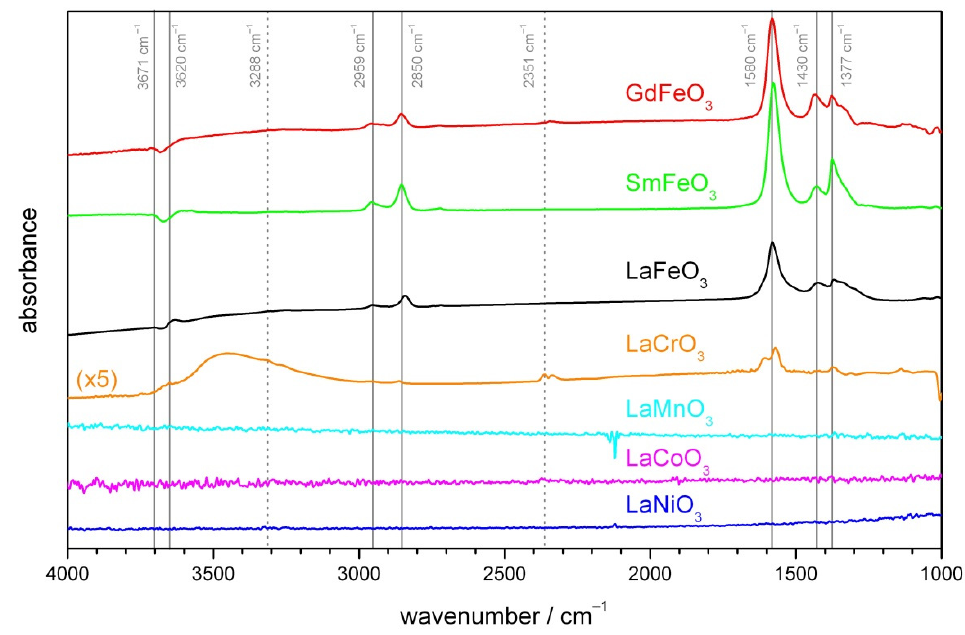
Figure 5. Absorbance DRIFT spectra of different materials at 150 °C. The spectra recorded after 2 h of exposure to 500 ppm acetylene were referenced to dry air. For increased visualization, the spectra are stacked and the magnitude of the spectrum of LaCrO 3 increases. The dashed lines mark the position of gas phase species.